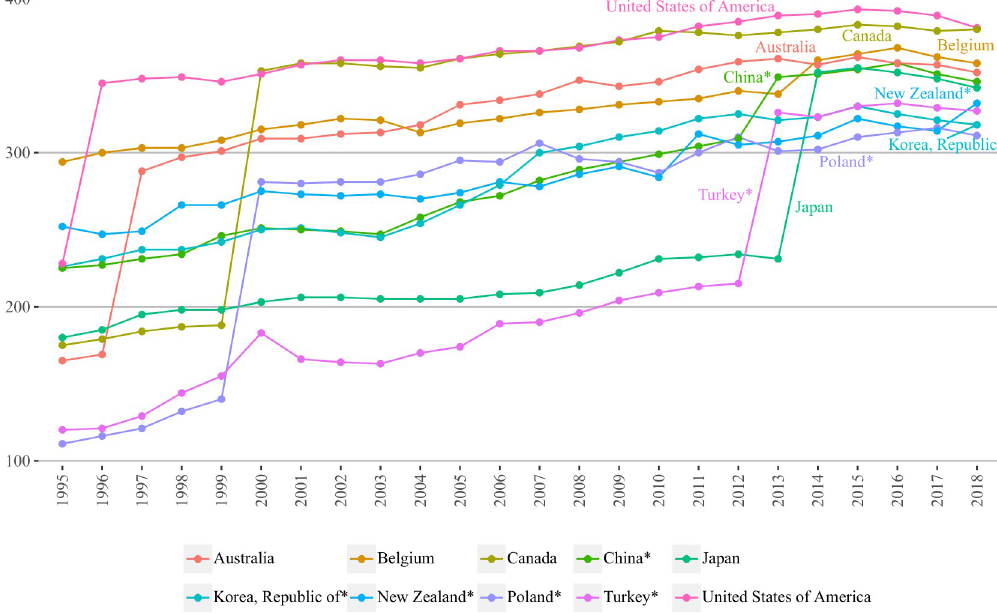
Fig 4. Degree centralities of top five BRI and non-BRI countries/regions over 1995–2018. Countries are selected based on the highest values of 2018 years; BRI marked with ‘ �